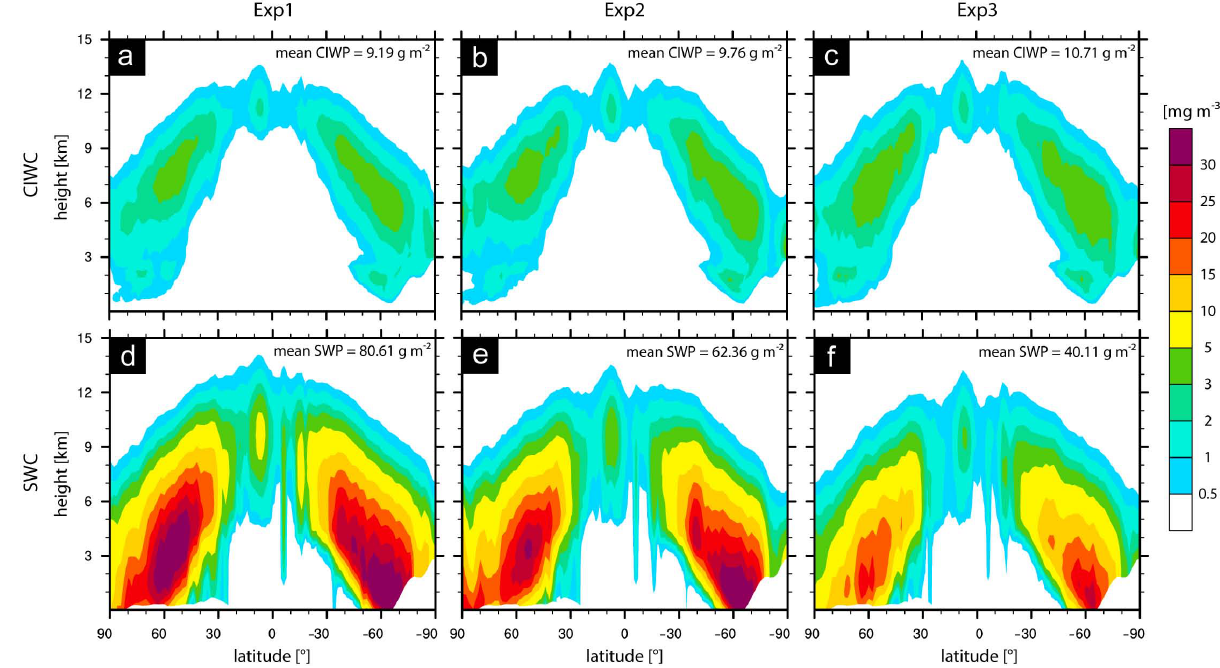
Fig. 8. Zonal averages of GME1007 for a 25 day period. Top row: Zonally averaged CIWC, bottom row: Zonally averaged SWC. Left column: Exp1, middle column: Exp2, right column: